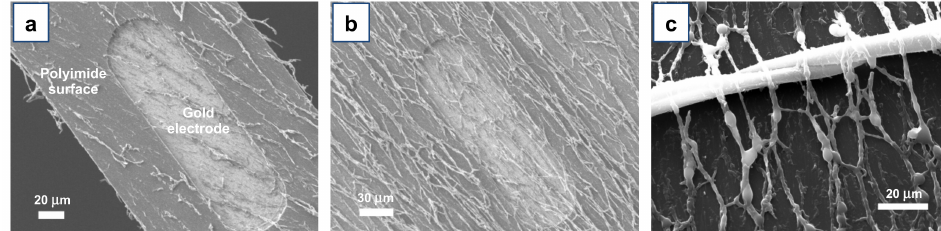
Figure 8. SEM images of Directional ASB-SANS-grown PLGA nanofibers developed over hetero- geneous substrates, constituted by a PI and gold, using M400 ( a ) and M200 ( b ) ternary solutions. ( c ) SEM micrograph of a microscopic cotton fiber (large white and almost horizontal fiber) surmounted by numerous PLGA nanofibers, perpendicularly placed on